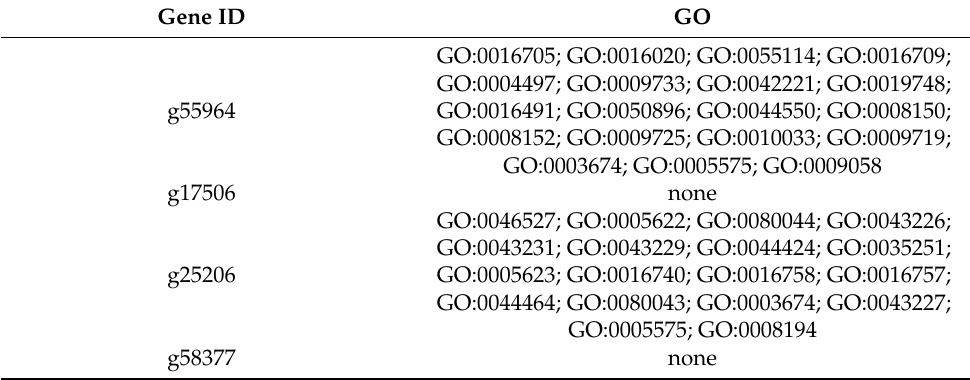
Table 3. GO analysis of candidate genes related to the RNA-seq